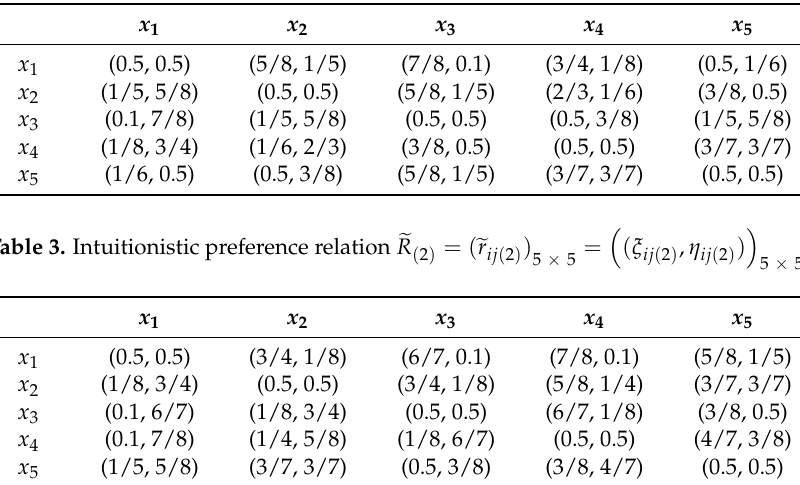
(cid:16) = ( ξ ij ( 1 ) , η ij ( 1 ) 5 × 5